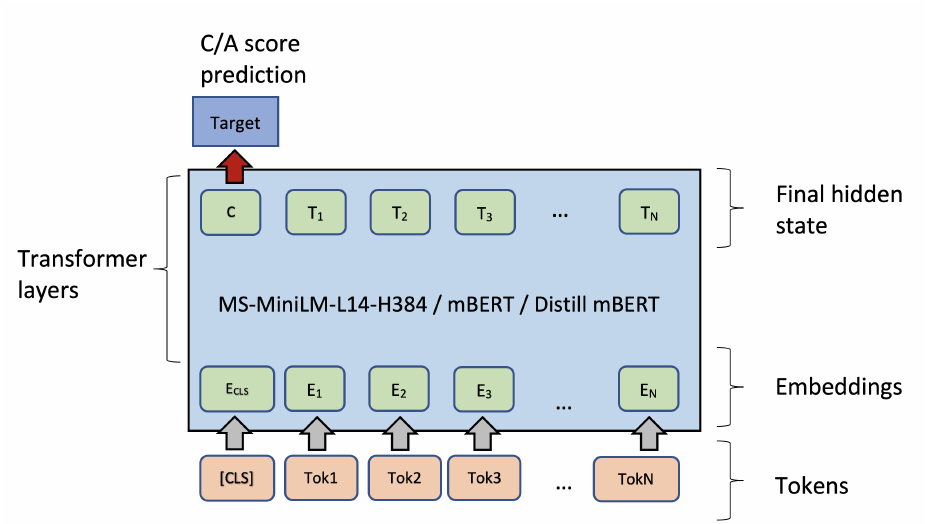
Figure 1. A schema of fine-tuning of transformer-based pre-trained models. Hidden representation of the [CLS] is used for